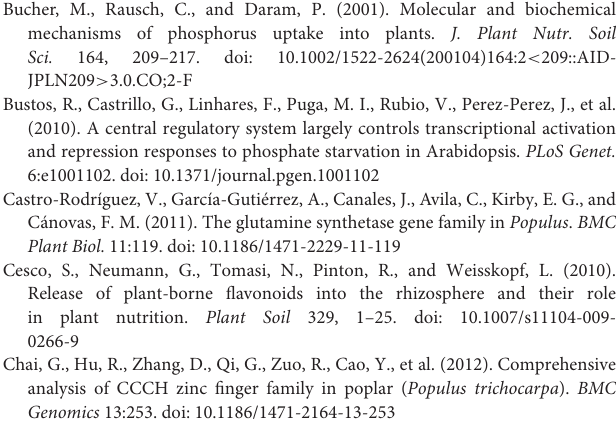
Table S1 | The primers used for quantitative real time PCR. Table S2 | Cis elements of PHT genes in Populus . Table S3 | The sequence similarity of PHT genes in Populus